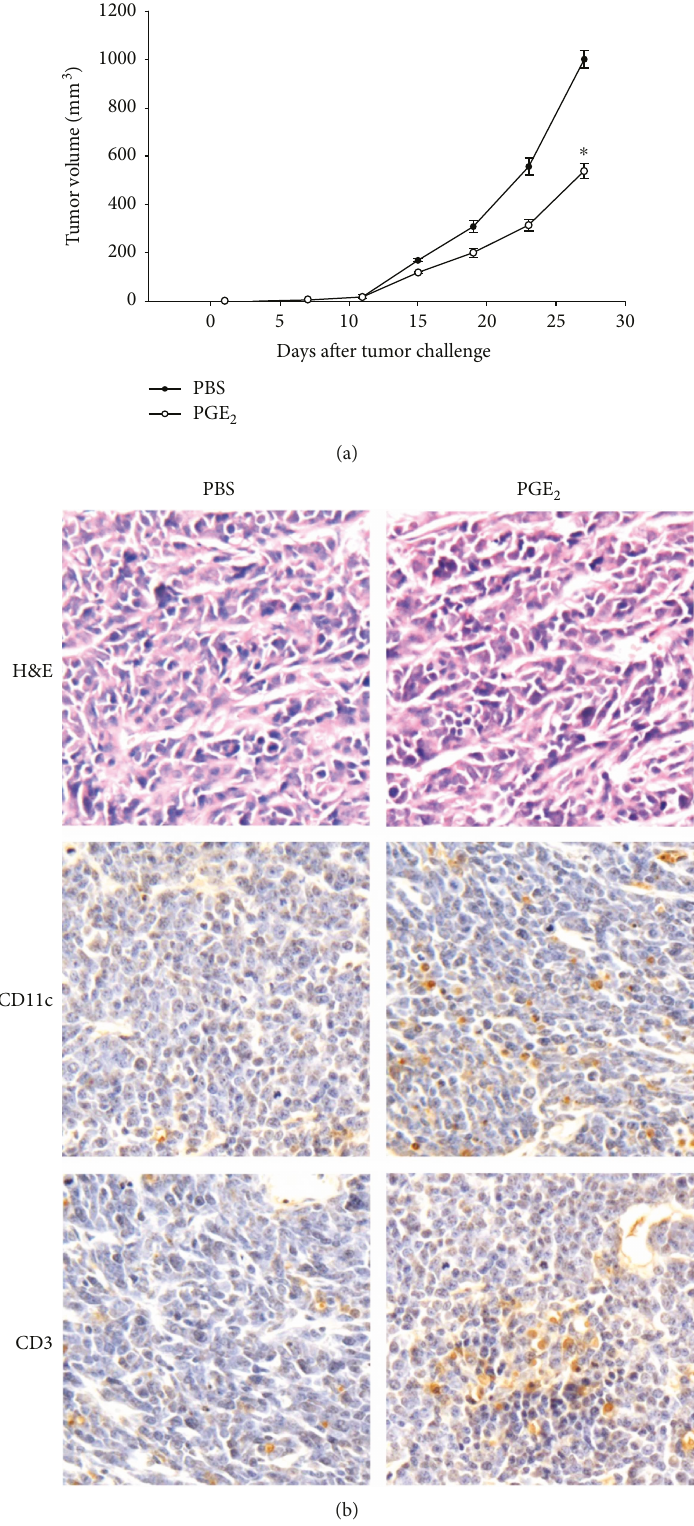
Figure 5: PGE inhibits RM-1 cell growth in mice with increased tumor-in fi ltrating T lymphocytes in tumor sites. Mice were challenged 2 subcutaneously with 2 × 10 5 RM-1 cells. PEG at 100 μ l of 0.15 μ g μ l − 1 or PBS was then intraperitoneally contralateral every 2 d in 2 total 6 times starting. (a) The tumor volume was monitored. ∗ P < 0 05 . (b) Immunohistochemical analysis of CD3 and CD11c in tumor sections using anti-mouse CD3 and CD11c antibody staining (brown). Original magni fi cation,